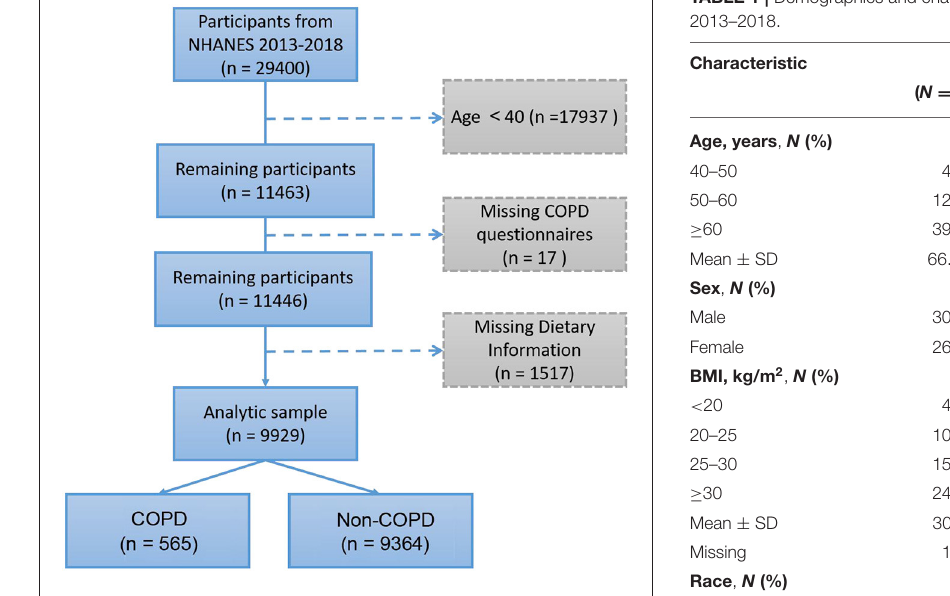
FIGURE 1 | Flow diagram of study participants.